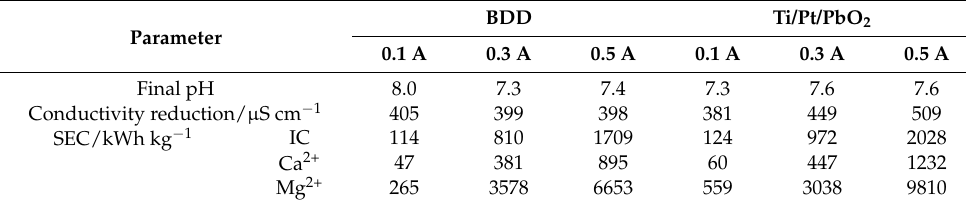
Table 3. Results for the final pH (initial pH = 7.9 ± 0.2), conductivity removal (initial conductivity = 1.7 ± 0.2 mS cm − 1 ) and specific energy consumptions per mass of inorganic carbon or calcium and magnesium removed, during electrolytic assays performed at different current intensities. BDD 20 cm 2 or Ti/Pt/PbO 2 10 cm 2 ; Cathode—SS 10 cm 2 ; Stirring speed—1000 rpm; 4 h.